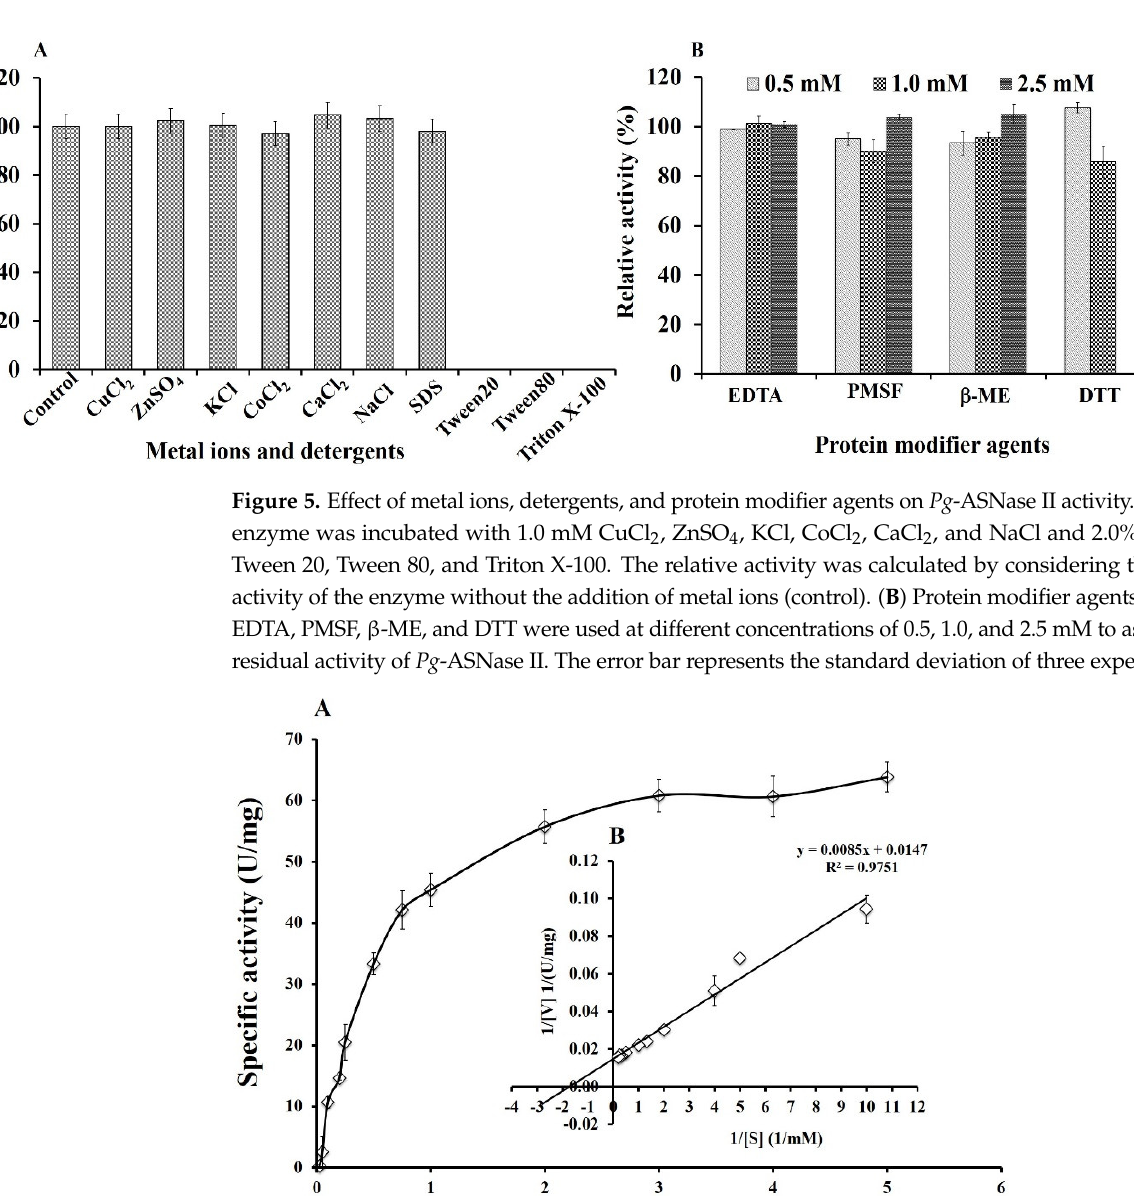
Figure 6. Kinetic study of His-tagged Pg -ASNase II. ( A ) Effect of varying L-asparagine concentration (0.10–5.0 mM) on Pg -ASNase II activity. ( B ) Lineweaver-Burk plot for determining a kinetic param- eter of Pg -ASNase II for L-asparagine. The error bar represents the standard error of three experi- ments.